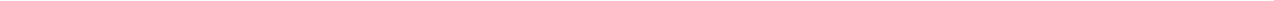
(Fig. 6a). CM-SASP is produced by IMR90 ER:RAS cells in which senescence is induced by means of the activation of a RAS- chimaeric fusion protein 12 .